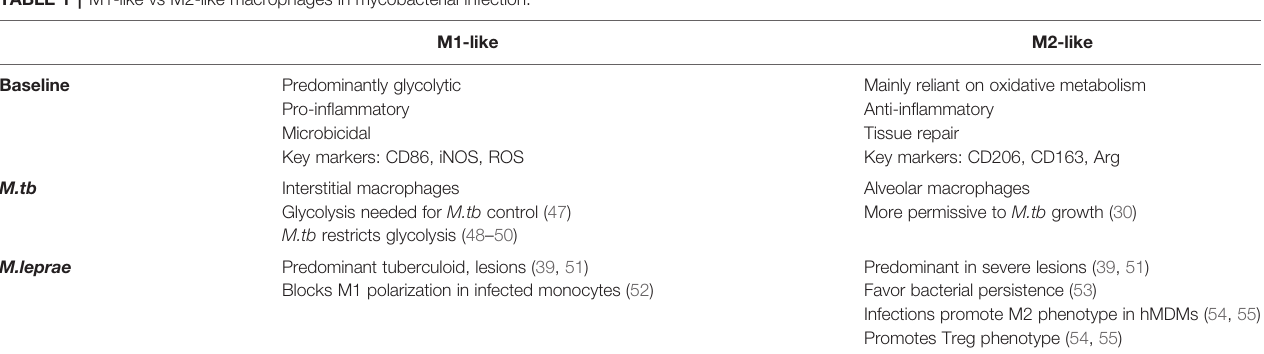
TABLE 1 | M1-like vs M2-like macrophages in mycobacterial infection. M1-like M2-like Baseline Predominantly glycolytic Pro-in fl ammatory Microbicidal Key markers: CD86, iNOS, ROS